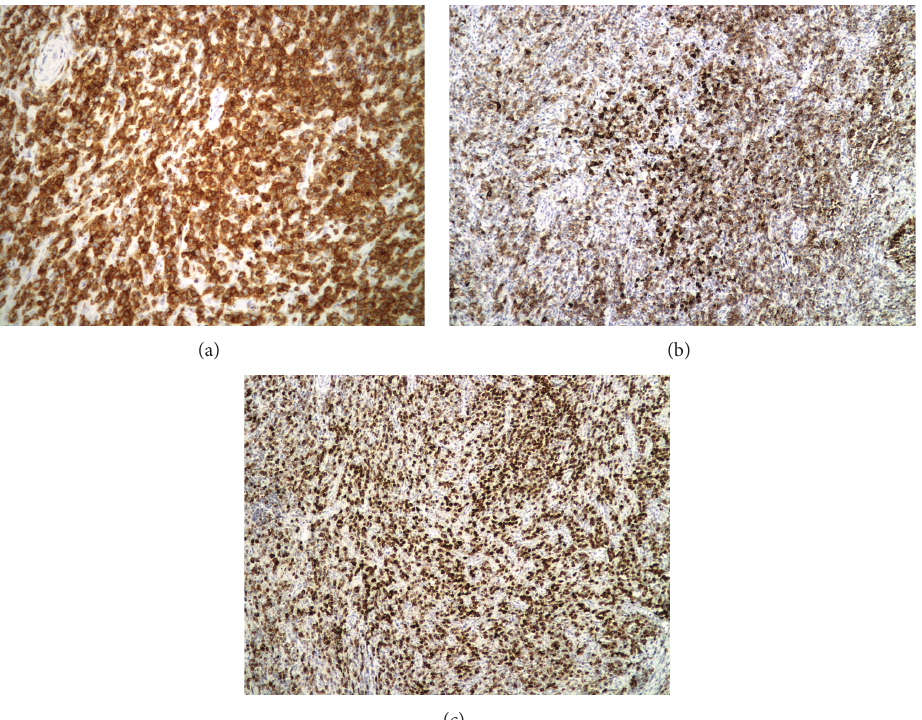
Figure 2: (a) Neoplastic cells demonstrating strong CD3 positivity (200x magnification), (b) neoplastic T cells with aberrant CD20 positivity (100x magnification), and (c) neoplastic T cells with aberrant CD79a positivity (100x